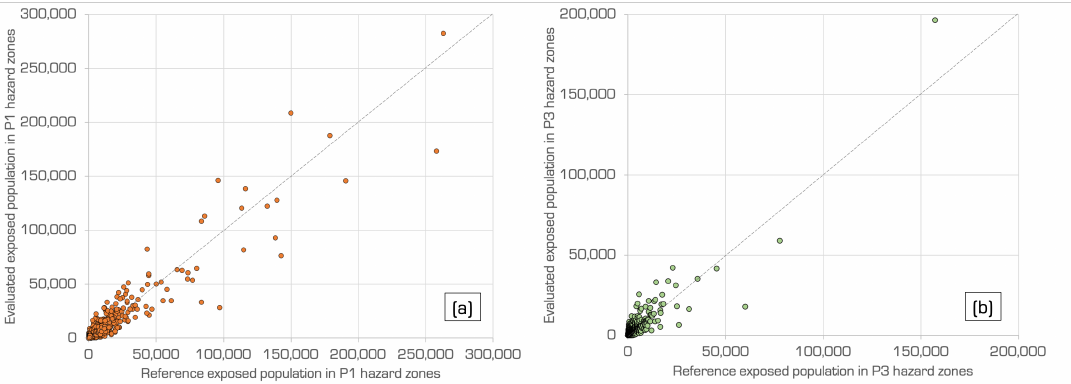
Figure 10. Scatter-plots that show the correlation between estimated and reference exposed population at municipal scale in Italy for P1 ( a ) and P3 ( b ) hazard